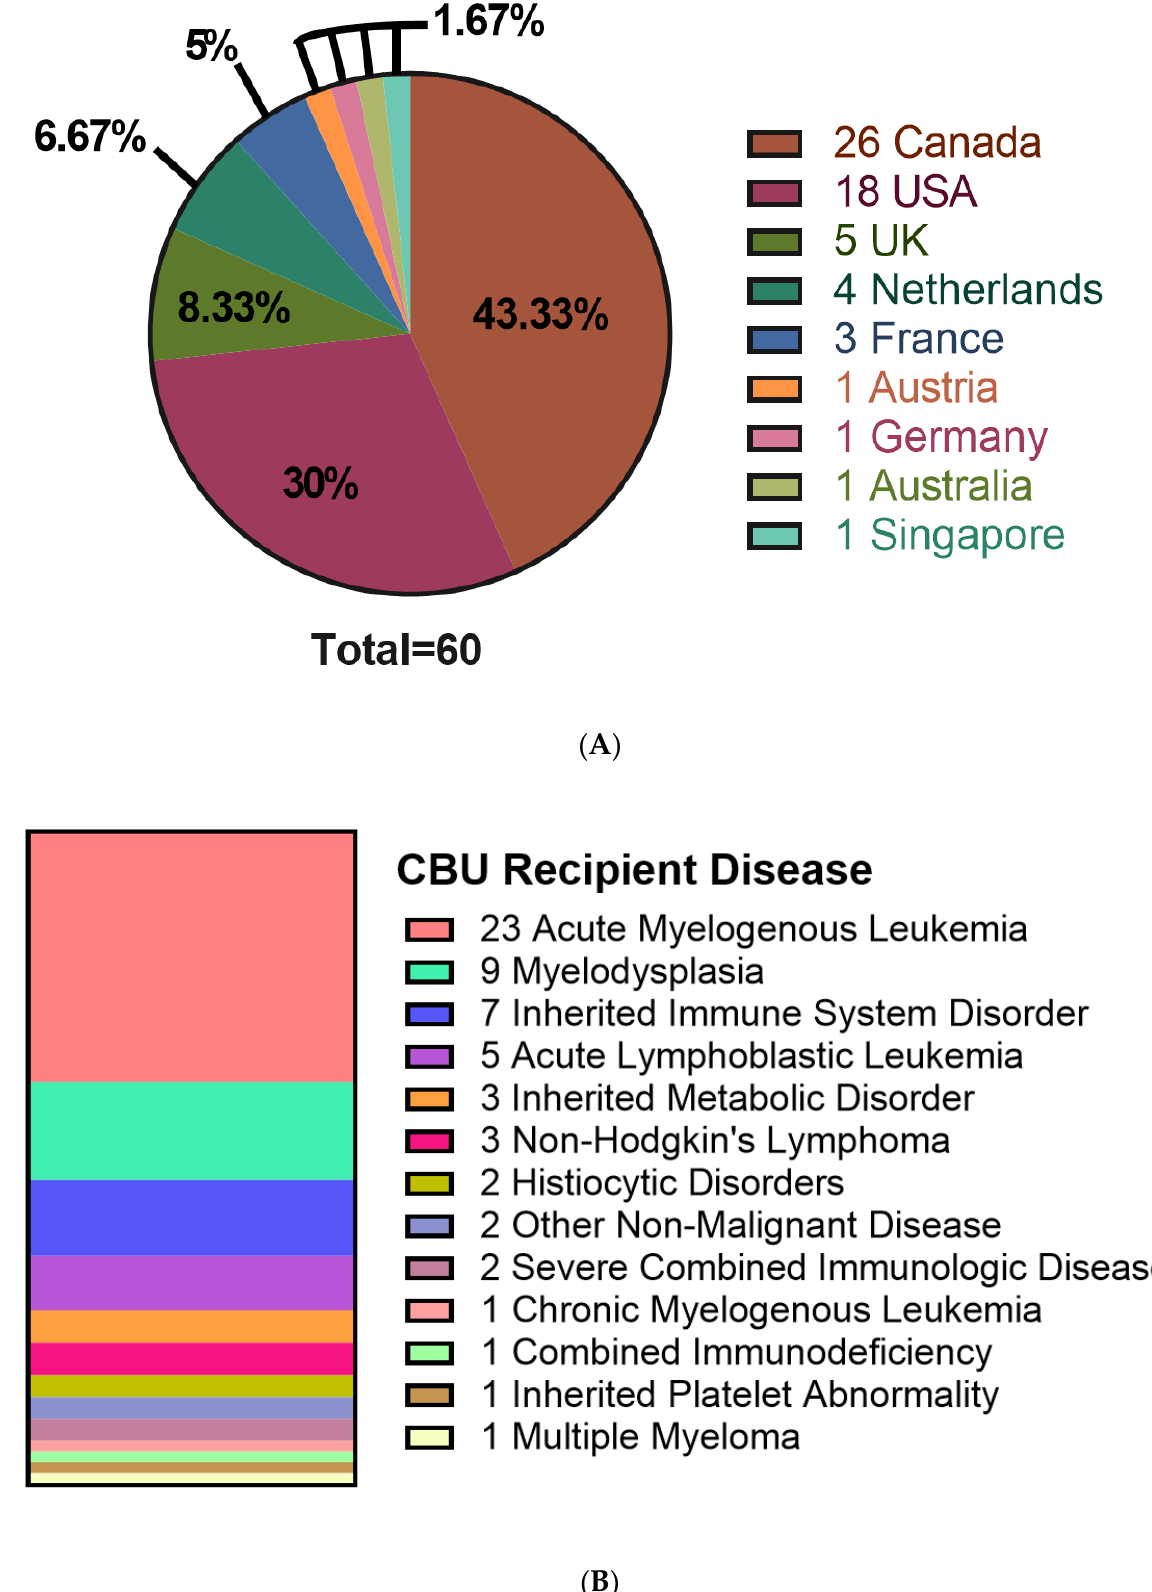
Figure 2. Characteristics of recipients receiving cord blood units from the CBS cord blood bank. ( A ) Location of patients receiving distributed CBUs. ( B ) Disease of patients receiving CBU donations. N = 60.